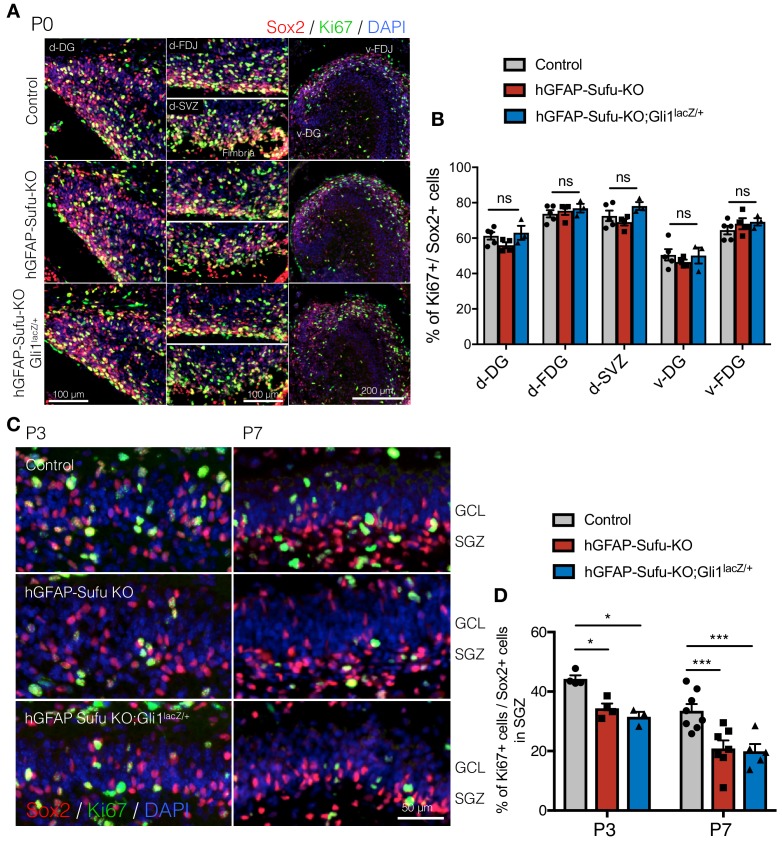
Deletion of Sufu prematurely decreases the proliferation of NSCs during DG development.(A) Representative immunofluorescence images of Sox2 (red) and Ki67 (green) in the dorsal and ventral DG of control, hGFAP-Sufu-KO and hGFAP-Sufu-KO;Gli1lacZ/+ mice at P0. DNA is stained with DAPI (blue). d: dorsal, v: ventral, FDJ: fimbriodentate junction; SVZ: subventricular zone. (B) The bar graph indicates the ratio of Ki67 +cells to Sox2 +NSCs in DGs [Control, n = 5; hGFAP-Sufu-KO, n = 4; hGFAP-Sufu-KO;Gli1lacZ/+, n = 3]. (C) Representative immunofluorescence images of Sox2 (red) and Ki67 (green) in SGZ of control, hGFAP-Sufu-KO and hGFAP-Sufu-KO;Gli1lacZ/+ mice at P3 and P7. (D) The bar graph indicates the ratio of Ki67 +cells to Sox2 +NSCs in DGs [P3: Control, n = 4; hGFAP-Sufu-KO, n = 4; hGFAP-Sufu-KO;Gli1lacZ/+, n = 3; P7: Control, n = 8; hGFAP-Sufu-KO, n = 7; hGFAP-Sufu-KO;Gli1lacZ/+, n = 5]. Values represent mean ±SEM; ns: p>0.05, *p<0.05, ***p<0.001. ANOVA with Tukey post-hoc tests.10.7554/eLife.42918.027Figure 6—figure supplement 2—source data 1.Extended numerical data and statistical analysis for Figure 6—figure supplement 2.